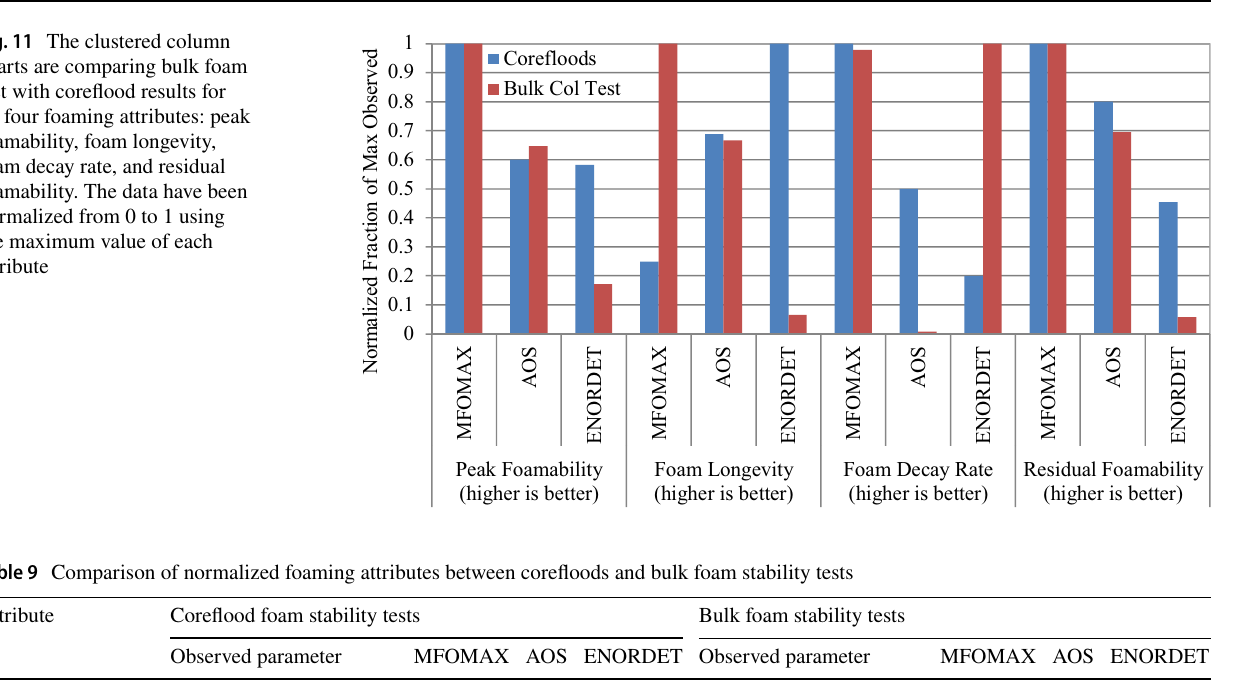
PV required to drop DP from peak to valley (PV) Residual foamability DP at the valley